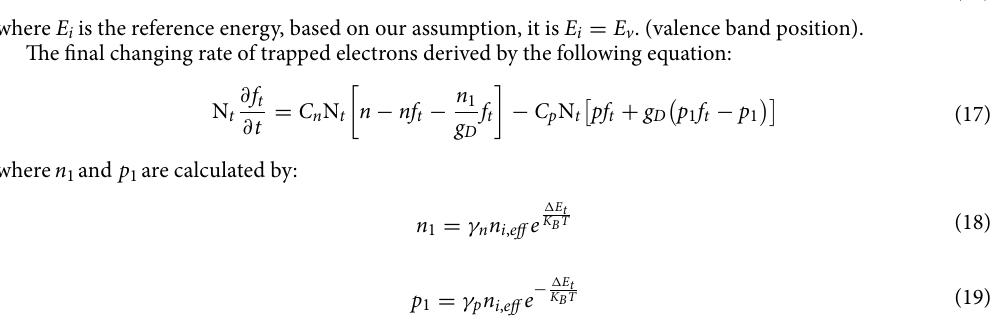
Figure 3 indicates the effect of the